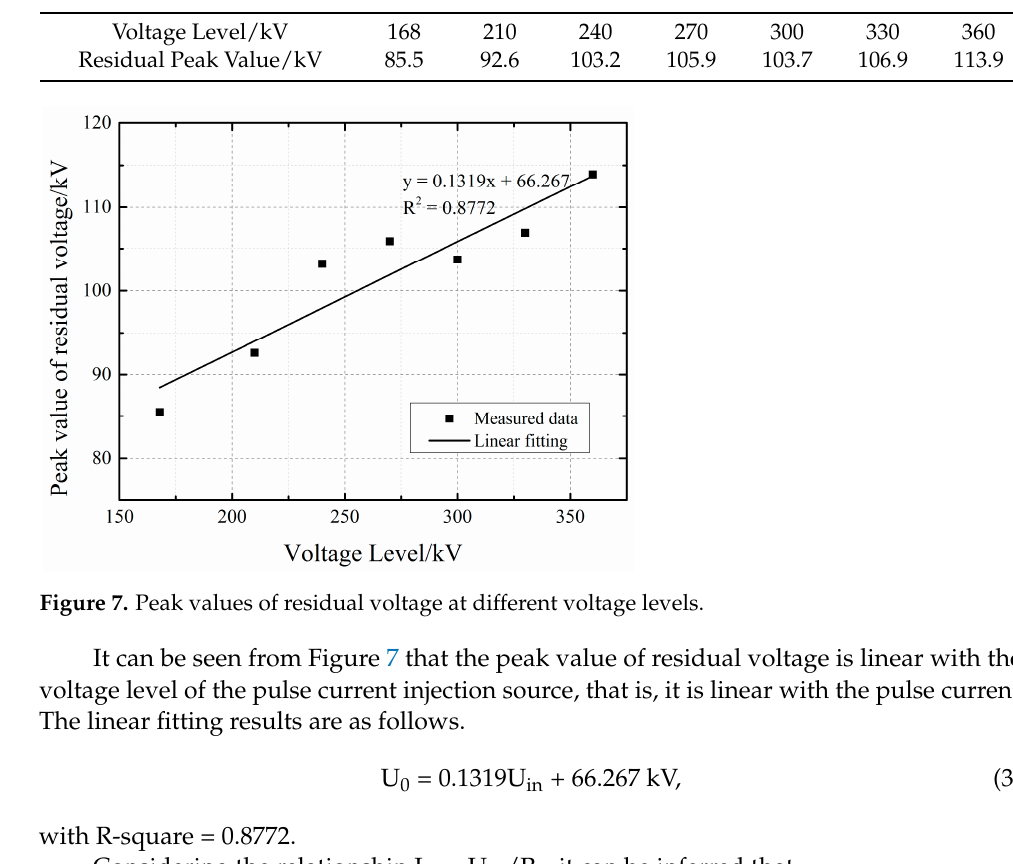
Table 3. The peak values of MOV residual voltage.